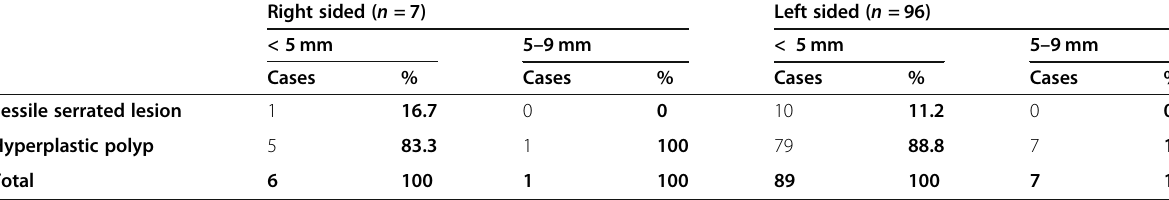
Table 3 Final diagnosis in relation to polyp site and